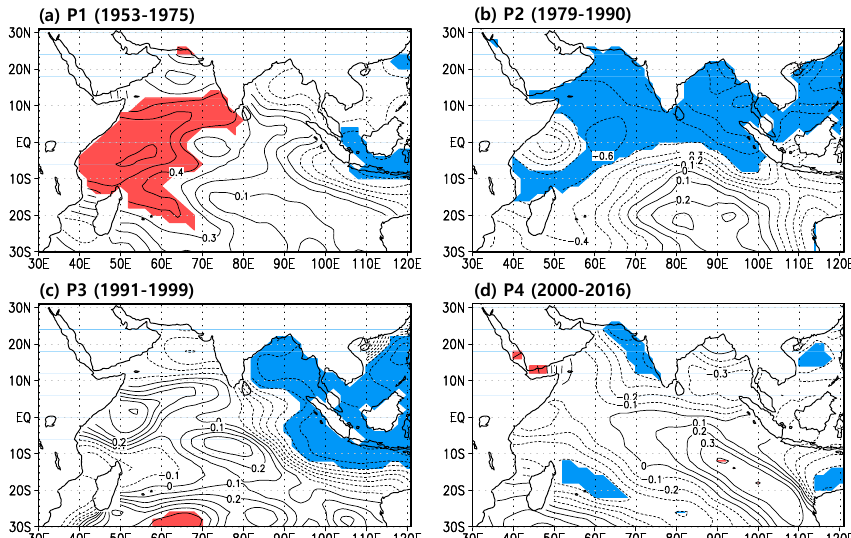
Figure 3. Correlation distributions of the high pass filtered summer SSTA in the tropical IO with the EASMI in ( a ) 1953–1975, ( b ) 1979–1990, ( c ) 1991–1999, ( d ) 2000–2016. The contour interval is 0.1 and shading (Red: positive, Blue: negative) shows the significance at the 90% confidence level with the Student’s t -test in each period.